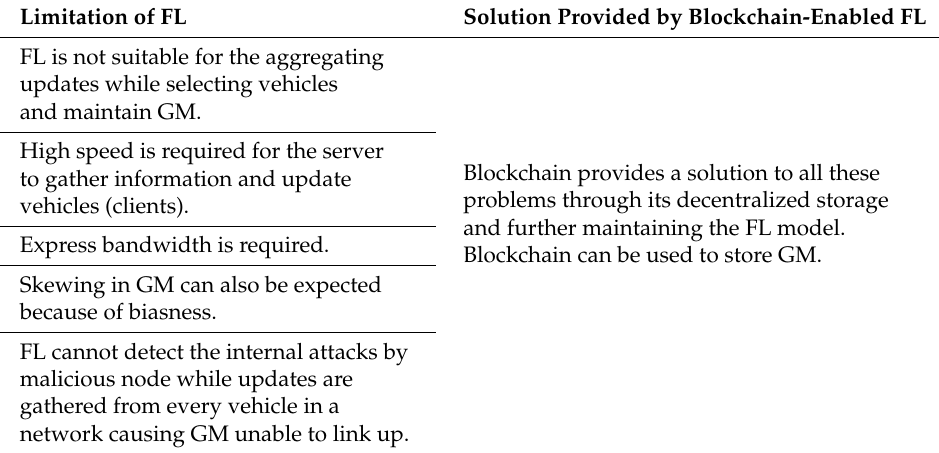
Table 3. Blockchain-enabled federated